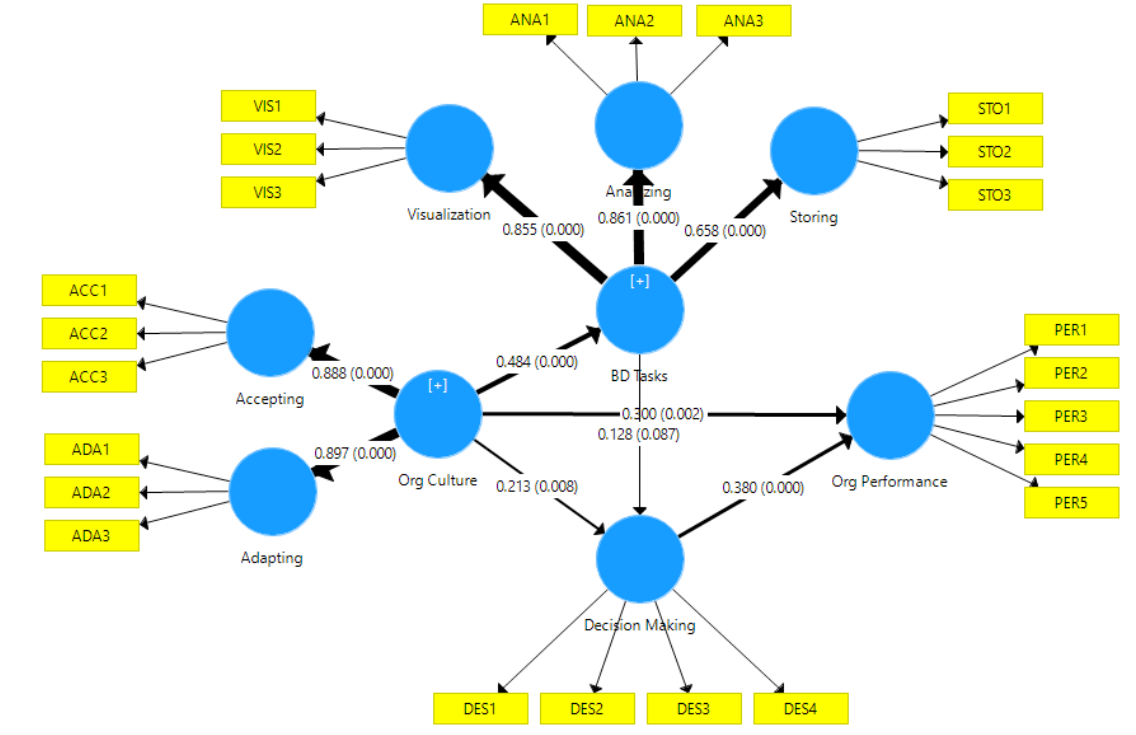
Figure 3. Structural model based PLS-SEM analysis Table 3. Hypotheses